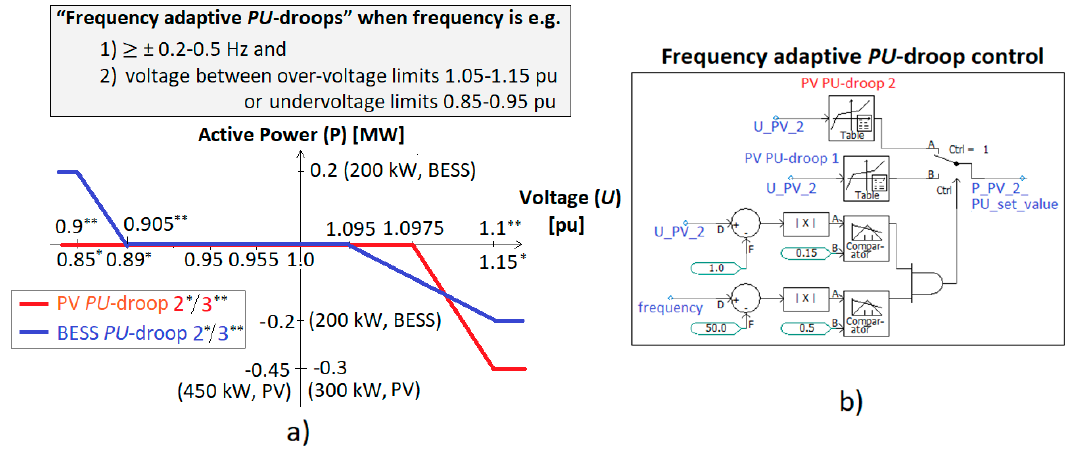
Figure 7. ‘Frequency adaptive PU -droops’ ( a ) idea and settings for PVs and BESSs during larger under and over-frequency situations and ( b ) PSCAD implementation of the PV and BESS droops 2.